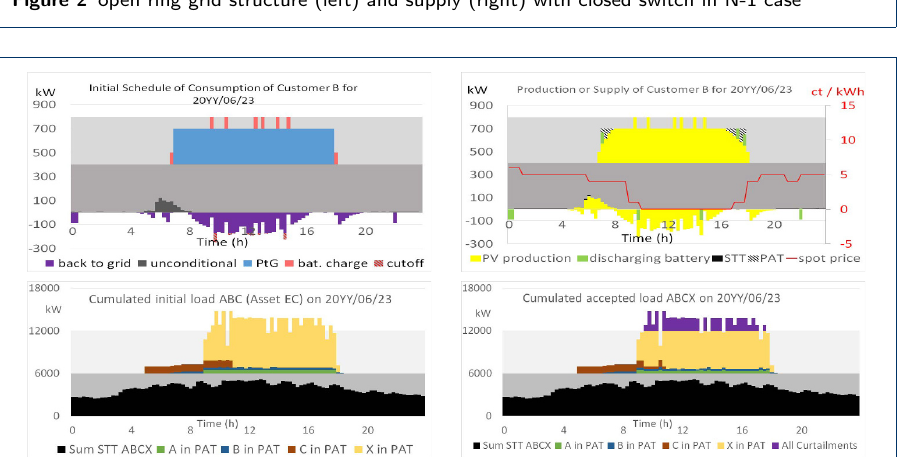
Simulation settings and